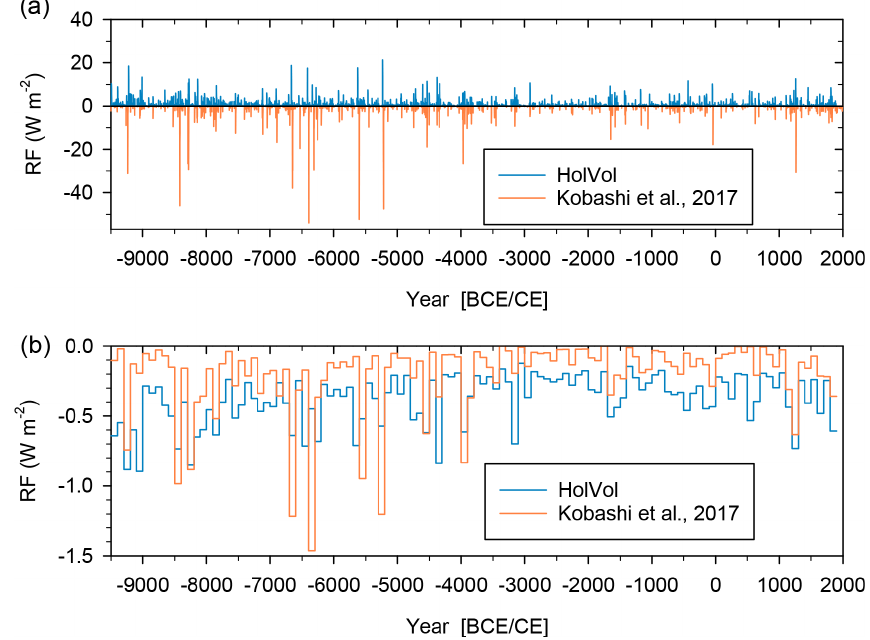
Figure 10. (a) Global mean radiative forcing (RF) from the EVA(HolVol) reconstruction (inverted axis) and from a reconstruction based on the GISP2 ice core (Kobashi et al., 2017). (b) Centennial mean RF for the two